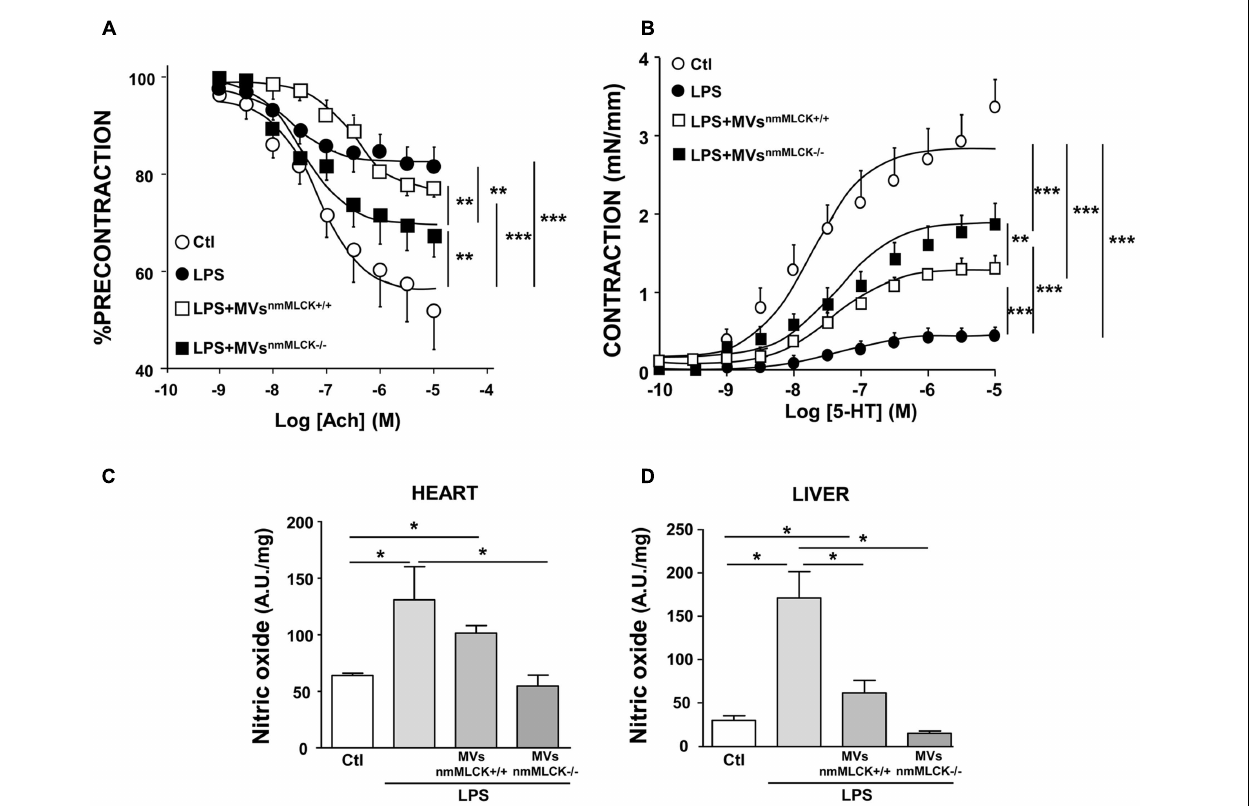
FIGURE 5 | Microvesicles from non-muscular myosin light chain kinase-deficient mice (MVs nmMLCK − / − ) improve the vascular function induced by LPS in vivo and the nitrative stress in heart and liver. Wild type mice were injected intravenously with saline salt solution (Ctl), MVs nmMLCK + / + , or MVs nmMLCK − / − . After 20 h, mice were injected intraperitoneally with LPS (40 mg/Kg) for 4 h. (A) Endothelium-dependent relaxation induced by acetylcholine (Ach) was evaluated by myography. The relaxation was expressed as a percentage of precontraction level. (B) Concentration-effect curves in response to 5-HT in aortic rings isolated from mice. Contraction are expressed in mN/mm. (C,D) NO production assessed by the amplitude of NO-Fe(DETC) 2 complex signal in unit/weight in heart (C) and liver (D) from mice. Data represent arbitrary units (A.U.) of the mean ± SEM/mg of tissue weight ( n = 3–5). ∗ P < 0.05, ∗∗ P < 0.01, ∗∗∗ P <